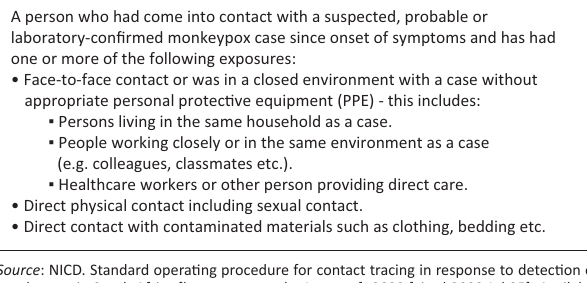
FIGURE 3: Contact definition of monkeypox. FIGURE 4: Assessed level of risk of the possible types of